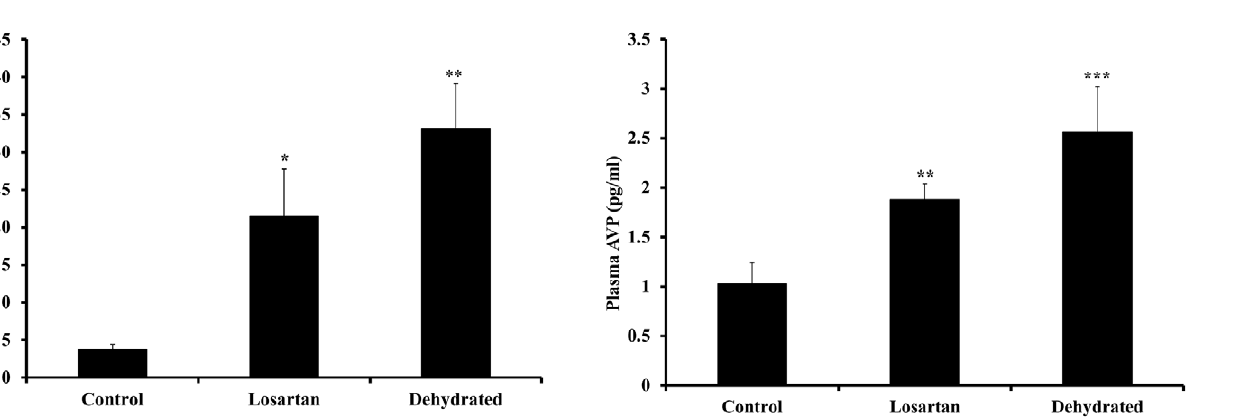
Figure 3. Plasma arginine-vasopressin in non-dehydrated (‘‘control’’, n=6), Losartan treated (n=6), and dehydrated camels (n=18) on day 20 of dehydration. Data are shown as mean 6 SEM. Significant difference from control is denoted by **p , 0.01 and ***p , 0.01.